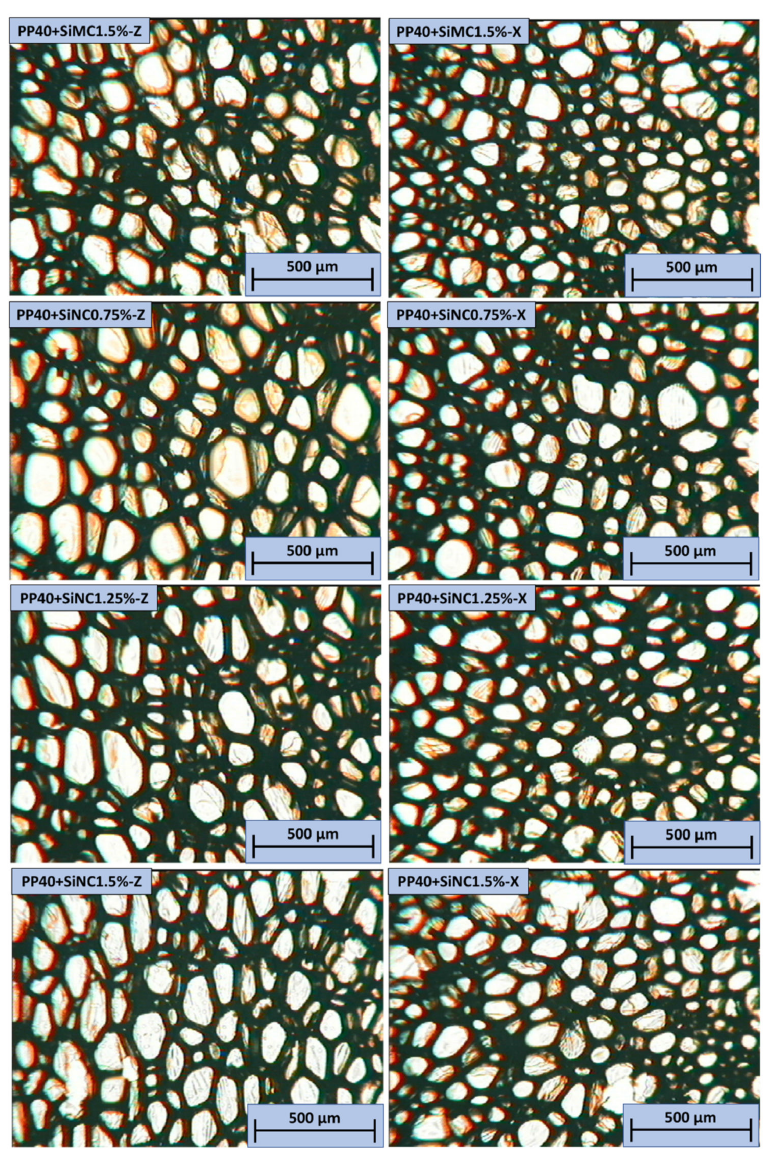
Figure 19. OM images of neat PP40 and SiMC and SiNC composites in both Z ( left ) and X ( right )